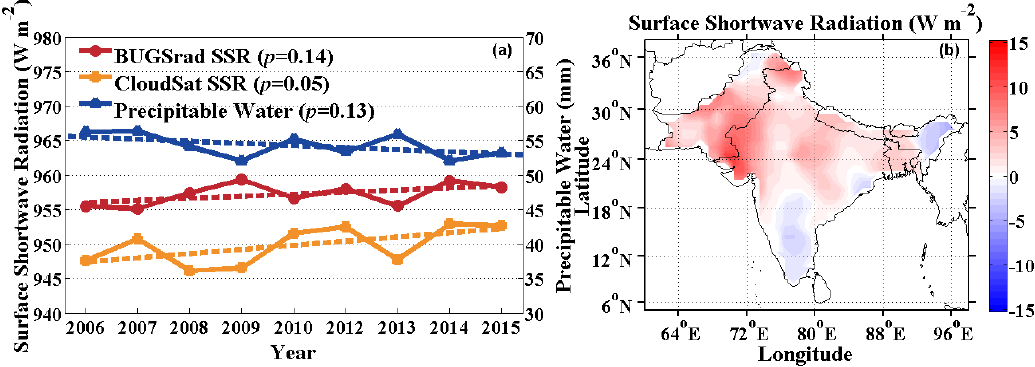
Figure 7. Temporal variations in spatial average ( a ) PW (blue line) and SSR in clear-sky conditions from BUGSrad (red line) and CloudSat (orange line); spatial distribution of temporal changes in average ( b ) SSR from BUGSrad in clear-sky conditions during the monsoon season in South Asia from 2006 to 2015. The dashed lines indicate the linear fit line of the solid line with the same color; p is the significance level.